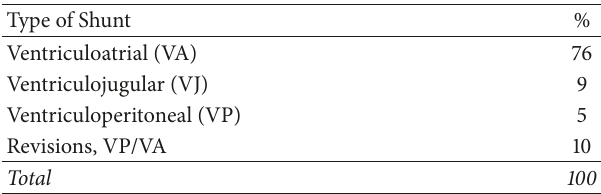
Table 1: Microbiologic characteristics of shunt nephritis. Table 2: Characteristics of shunts in shunt nephritis.